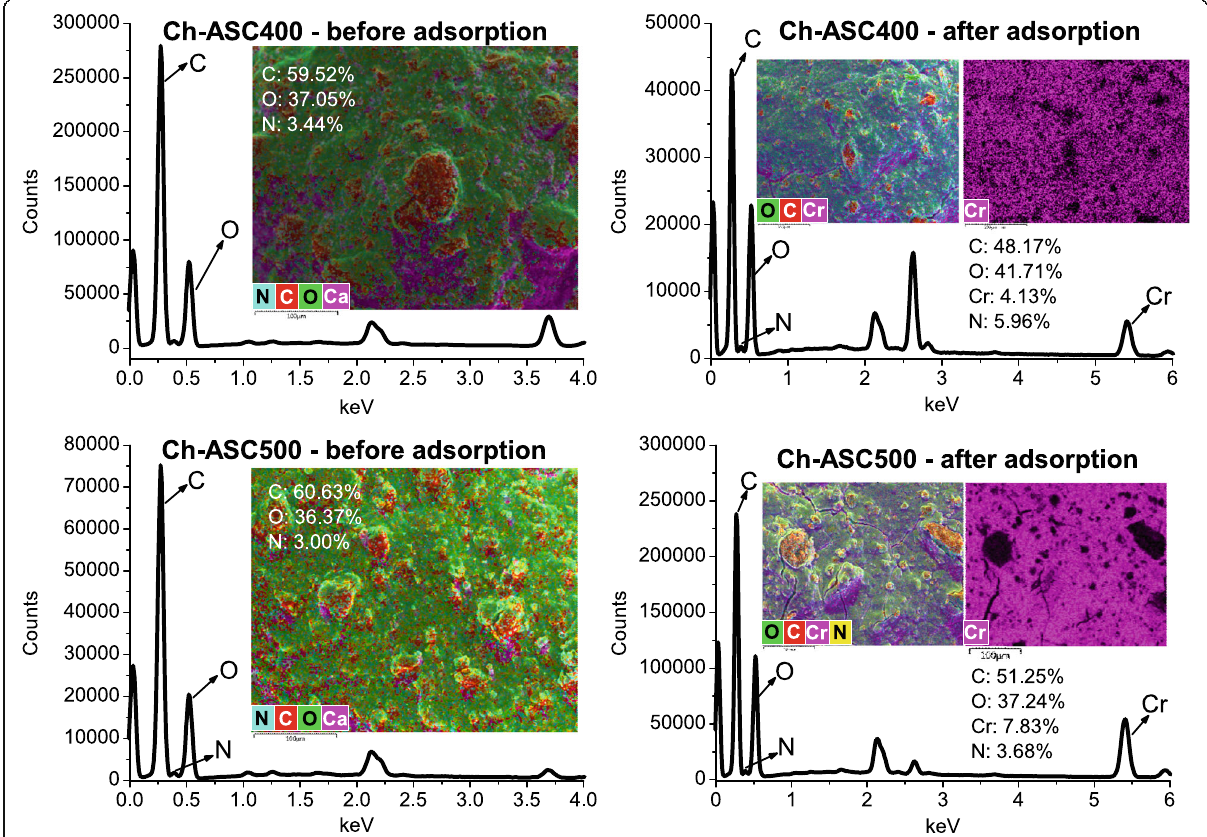
Fig. 6 EDX spectra and elemental mapping images of Ch-ASC400 and Ch-ASC500 before and after Cr(VI)